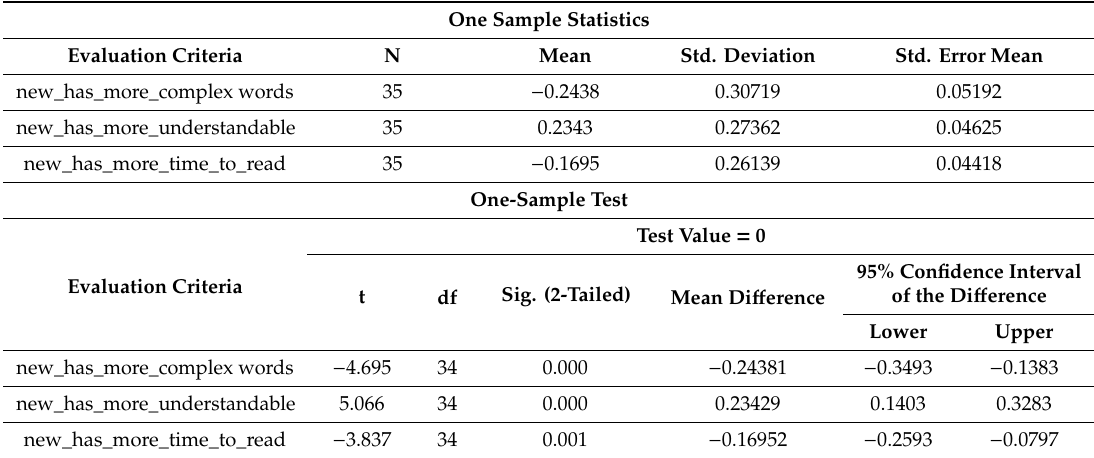
Table 7. Student data—new comment readability t -test values.